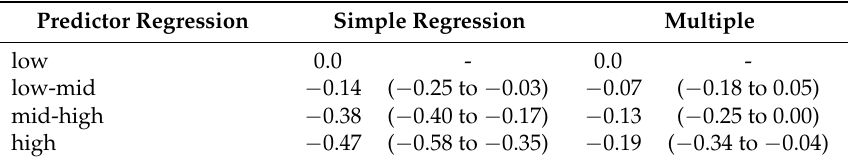
Figure 4. Mean BMI of conscripts living around the 445 stores in relation to the ( A , B ) area-based SEP and ( C , D ) the healthy sales balance (HSB) of the stores, either by language region (D = German, F = French, I = Italian) or by urbanicity class. Pearson correlation coefficients and ordinary regression lines are given for each subset of stores, and correlation coefficients are also given for all stores together. Confidence intervals for correlation coefficients are given in Table S1. Table 5. Coefficients (with 95% CI) from regression models for the effect of the healthy sales balance (HSB), categorized into quartiles, on the mean BMI of conscripts. The multiple regression model included the area-based SEP (socioeconomic position), language region and urbanicity as additional predictors to adjust for their confounding effects. The lowest HSB quartile is included in the table with a coefficient of 0 for